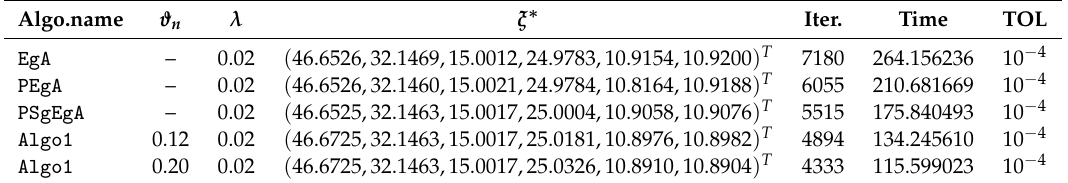
Figure 2. Comparison of Algorithm 1 with Algorithm 1 in [19], Algorithm 1 in [21], and Algorithm 3.1 in [35,36]. Table 4. Experiment in Section 6.1.2: Algorithm 1 comparison with existing algorithms using two different values of ϑ n .